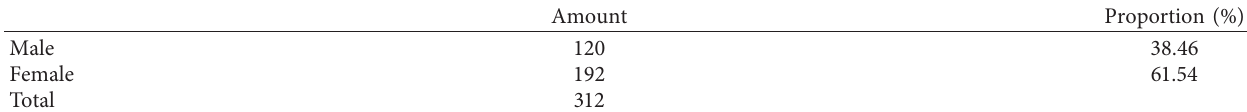
Table 2: Distribution of the respondents’